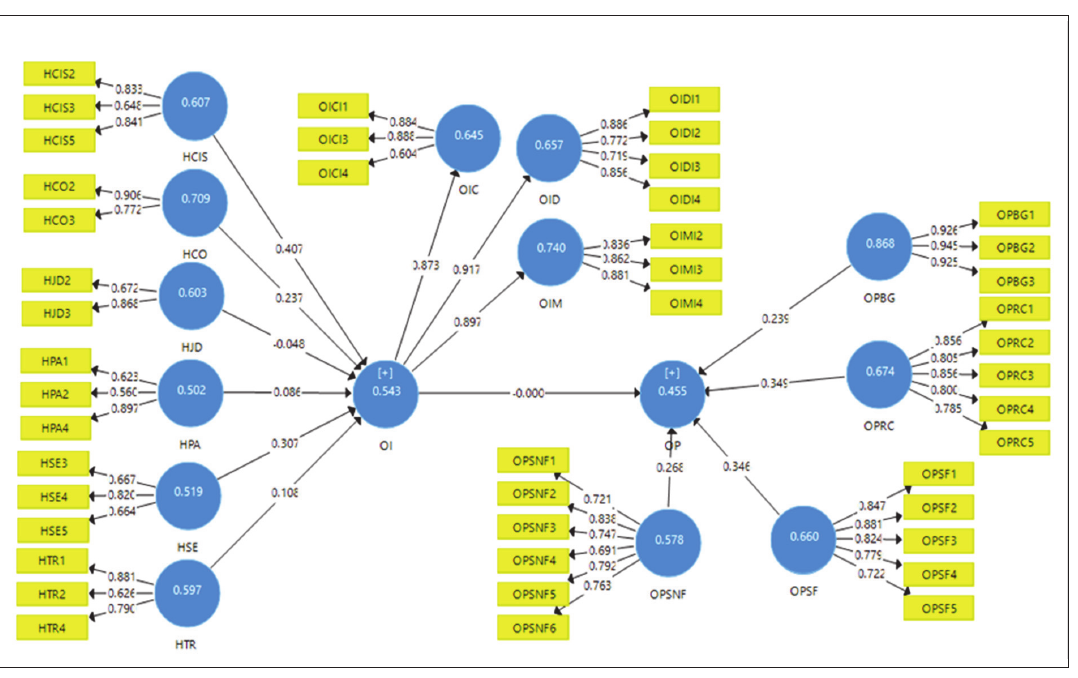
Fig. 1. Research Model of the